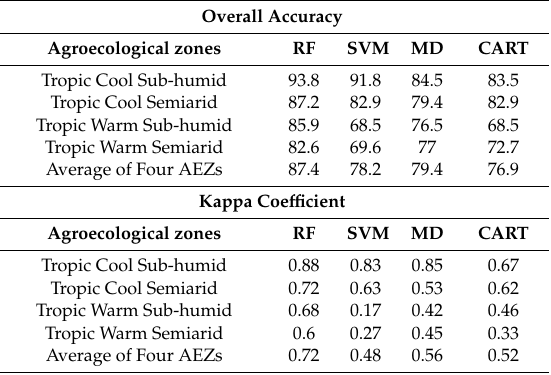
Table A1. Results of overall accuracy (OA) and kappa Coe ffi cient over the di ff erent AEZs based on the applied image classification methods.